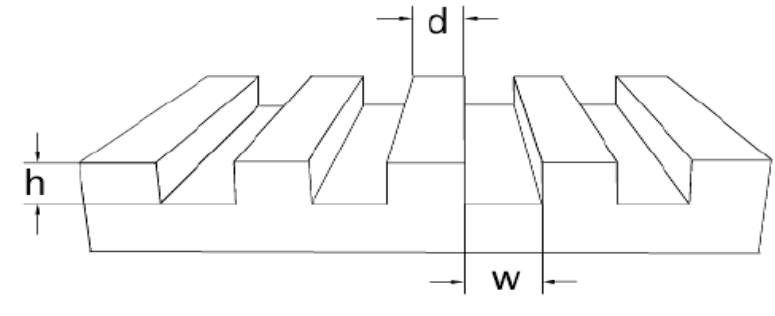
Figure 1 . Schematic view of a patterned silicon master. Figure 1. Schematic view of a patterned silicon